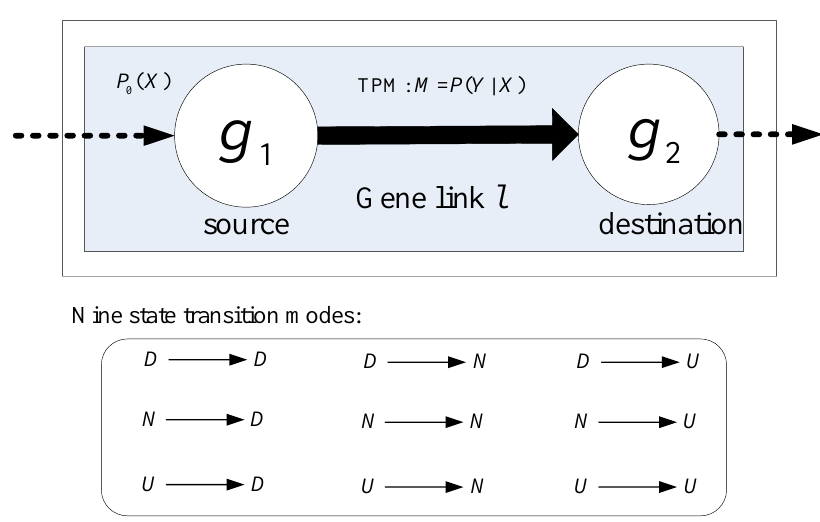
Figure 2. Markov chain model for a gene link (MCMLink). The box above illustrates a MCMLink l on a training set. Matrix M = P ( Y | X ) is the state transition probability matrix (TPM) of l on the training set. The box below shows all the nine possible regulatory state transition modes, downregulated (D), non-regulated (N) and upregulated (U), delivered by the link l .